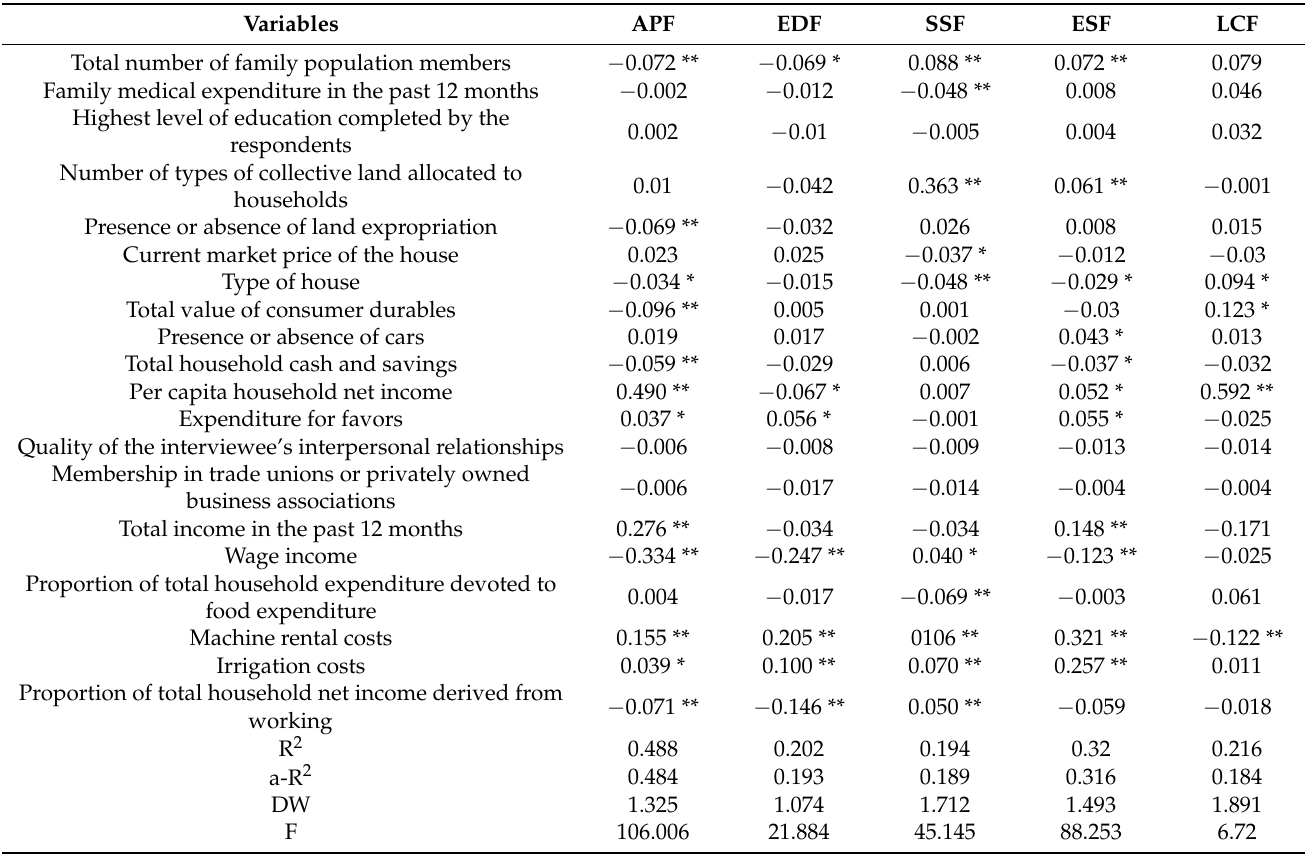
Table 7. Regression analysis of household livelihoods and agricultural